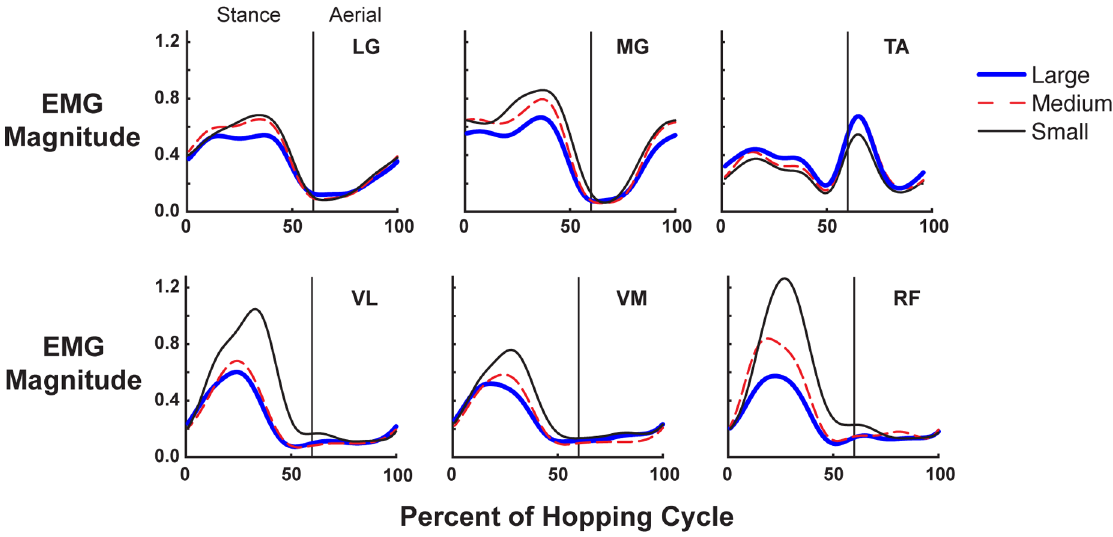
Figure 6. Muscle activity over time. Average normalized EMG activity for LG, MG, VL, VM and RF across the three target conditions (large: thick blue lines; medium: red dashed lines; small: thin black lines) for 100% of the hopping cycle (n=11). Muscle activity generally increased with smaller